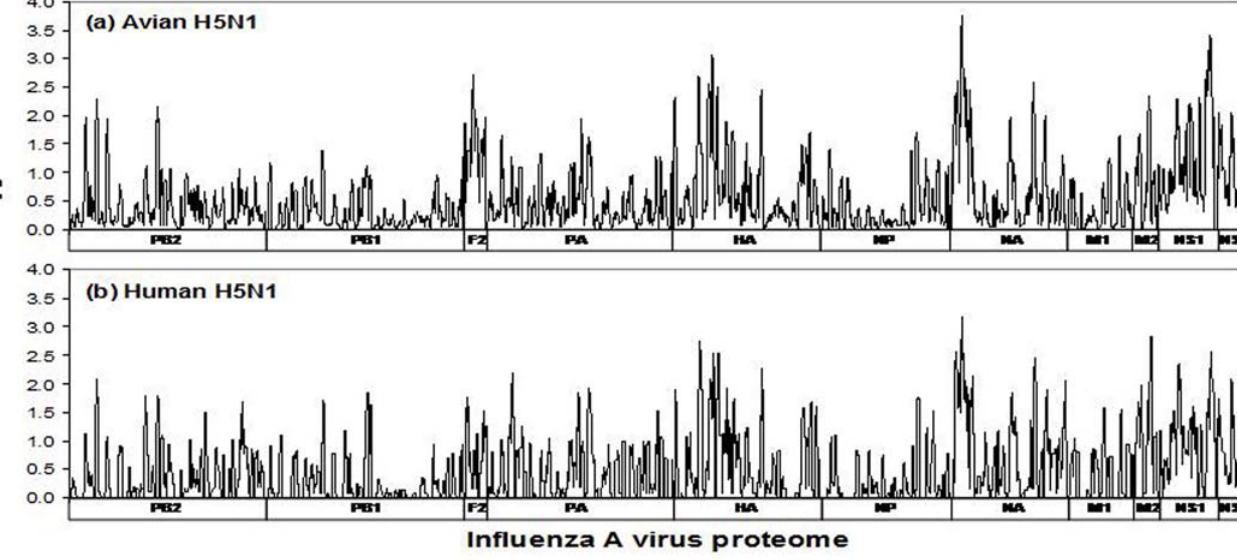
Figure 2. Entropy plots of avian influenza A viruses, excluding H5N1 subtype, for each of three decades: 1977–1986, 1987–1996, 1997–2006 (data as of September 30,